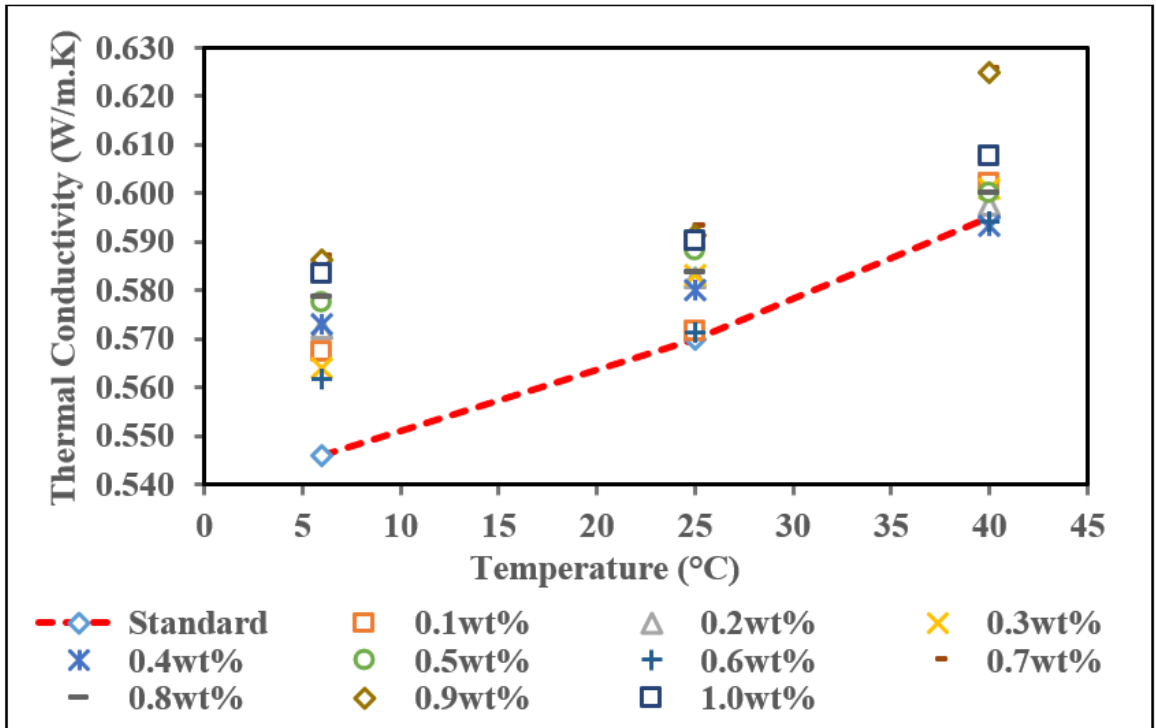
Figure 8. Thermal conductivity of commercial MWCNTs based nanofluid without PVP with various concentration at different temperatures. Table 5. Thermal conductivity enhancement of commercial MWCNTs nanofluid without PVP. Weight Concentration of Commercial MWCNTs